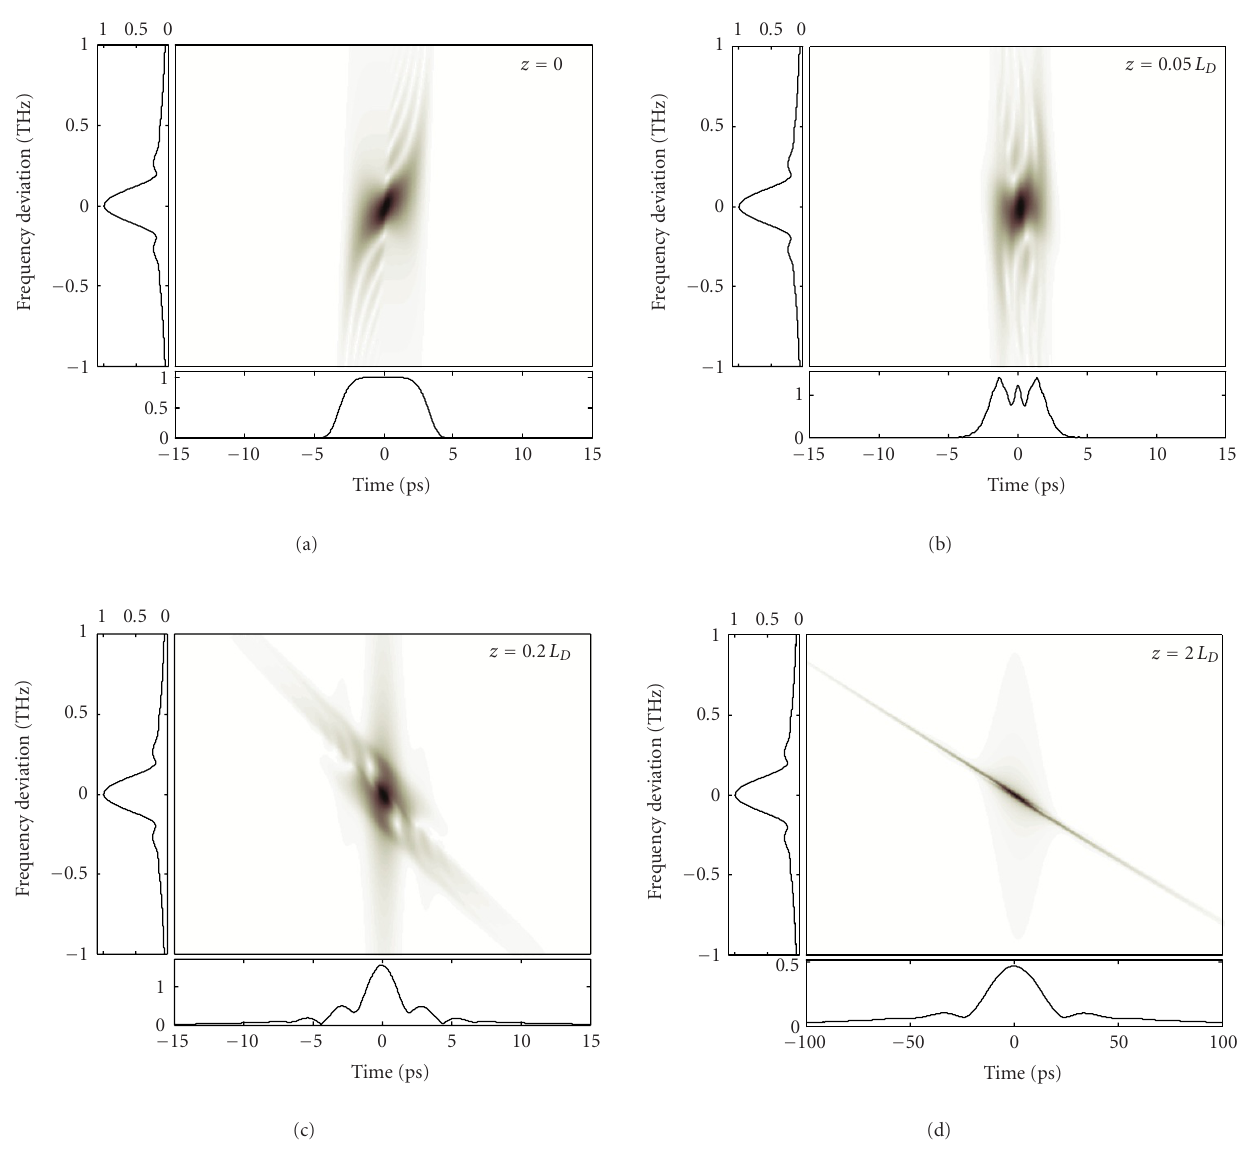
Figure 2: Wigner analysis of linear propagation of a chirped optical pulse through an optical fiber (first-order dispersion).